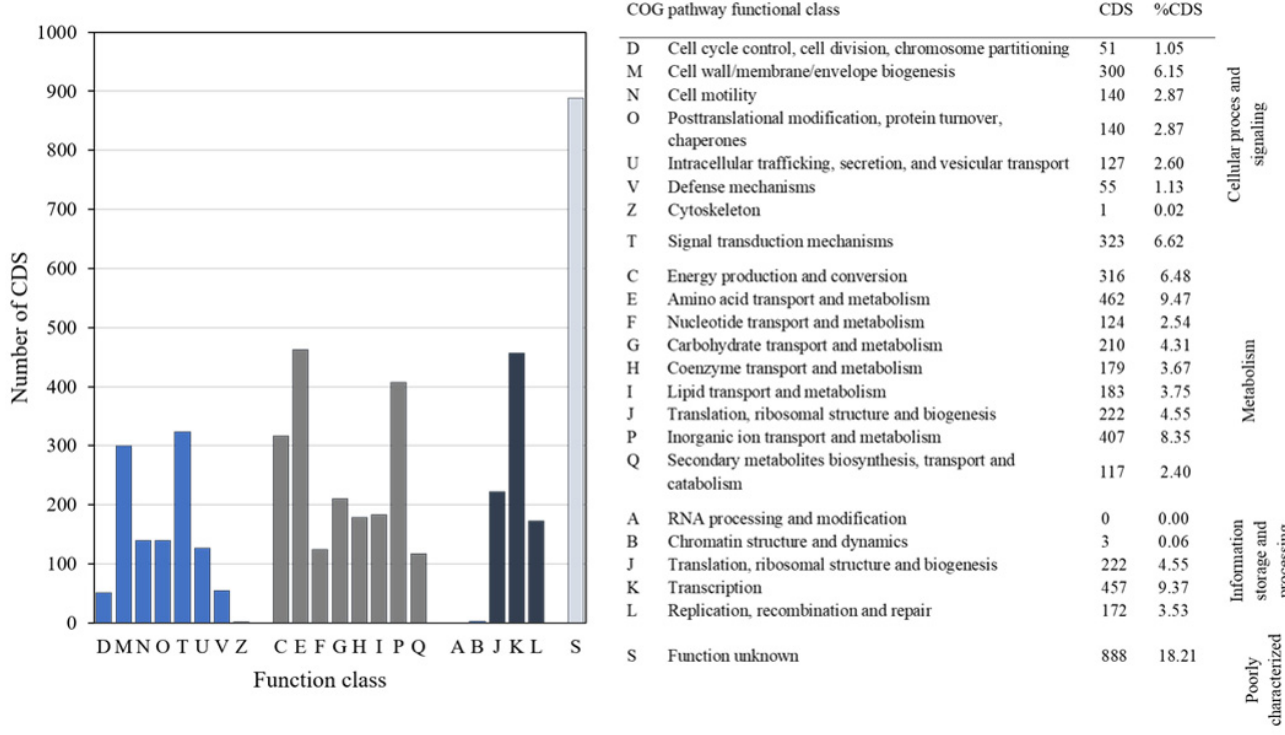
Figure 4. KEGG pathway classification of predicted genes in the ZCR6 strain using KEGG BlastKo- ala ( A ). Protein-coding sequences grouped into the functional subsystems in the ZCR6 genome us- ing RASTtk ( B ). 2.4. Plant Growth Promotion Potential 2.4.1. Nutrient (N, P, S, Fe) Acquisition Rhizospheric bacteria use various mechanisms of action to stimulate plant growth. First, due to their direct vicinity of plant roots, they enhance the bioavailability and uptake